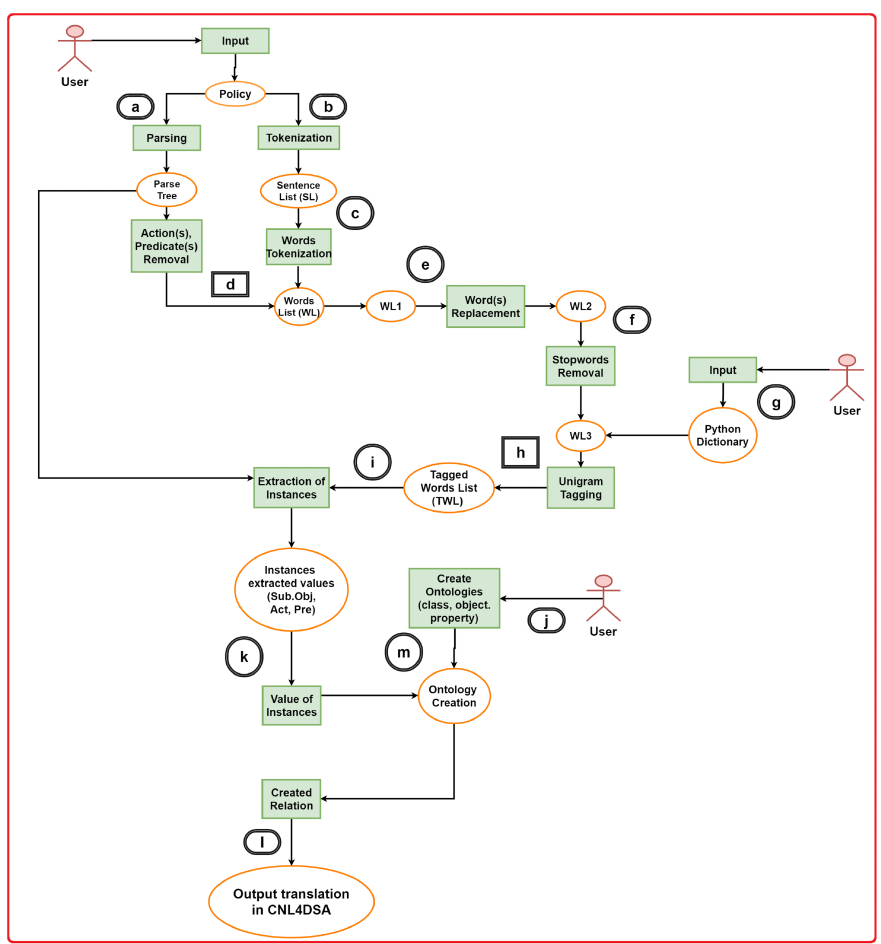
Figure 1. Pictorial representation of the system